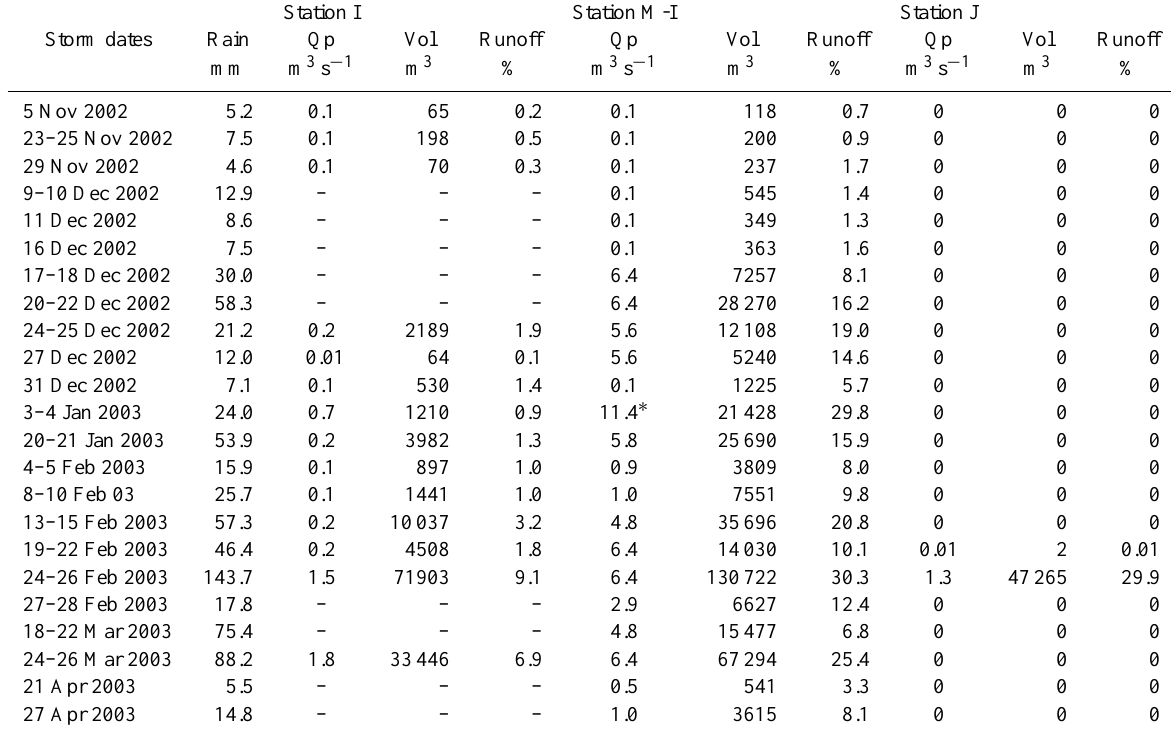
Table 3. Storm events in Modiin, winter 2002/2003.